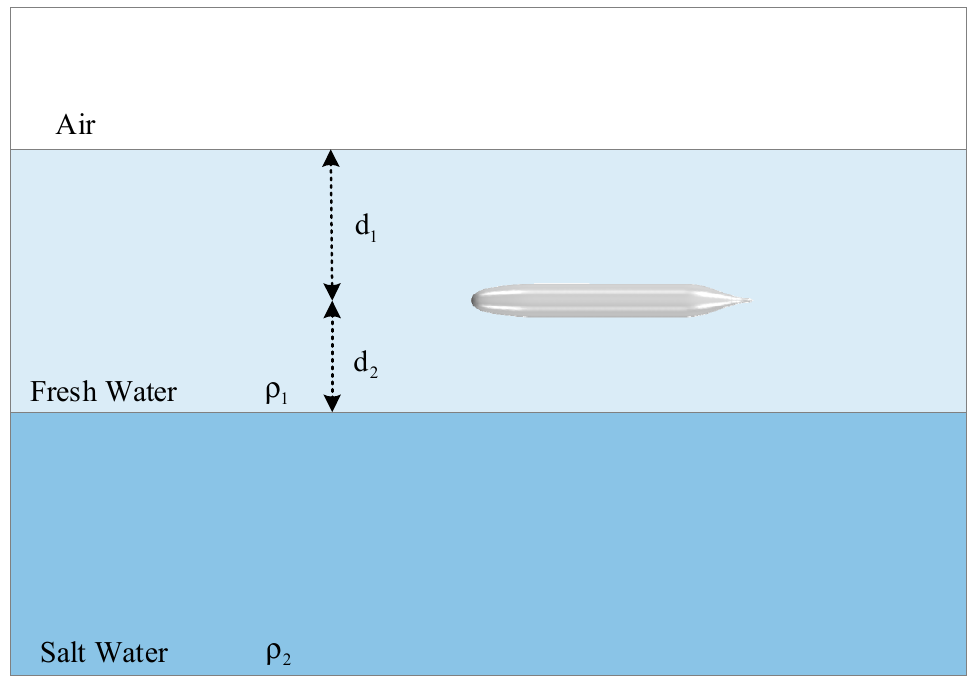
Figure 3. Model diagram.